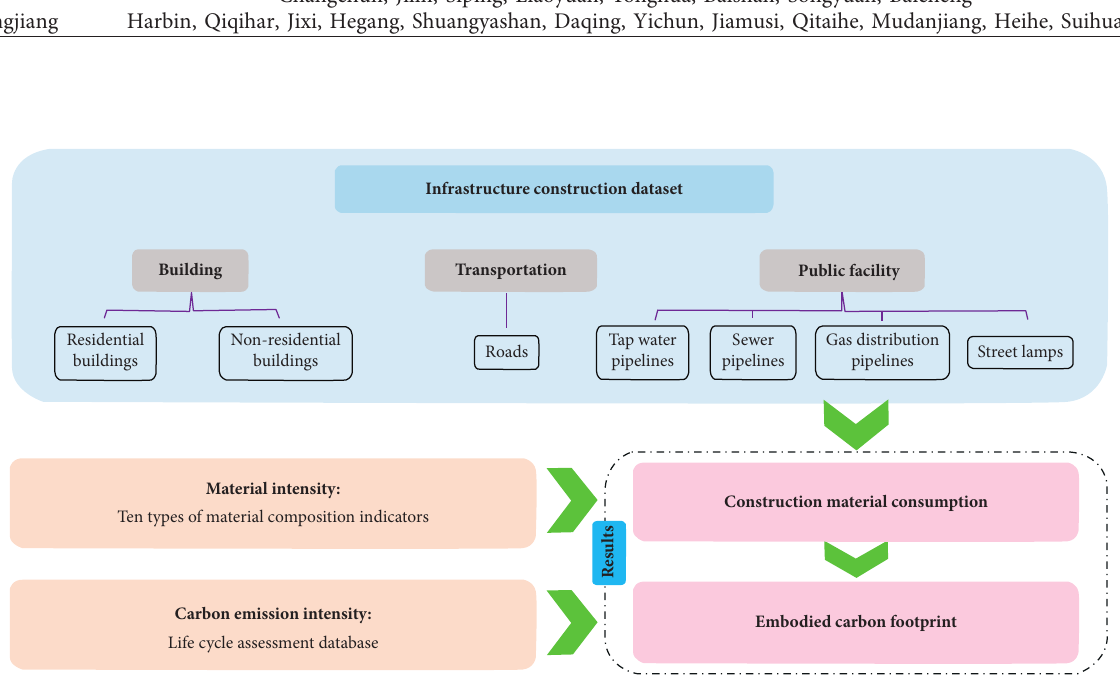
Figure 2: The framework underlying the material consumption and carbon emissions of infrastructure